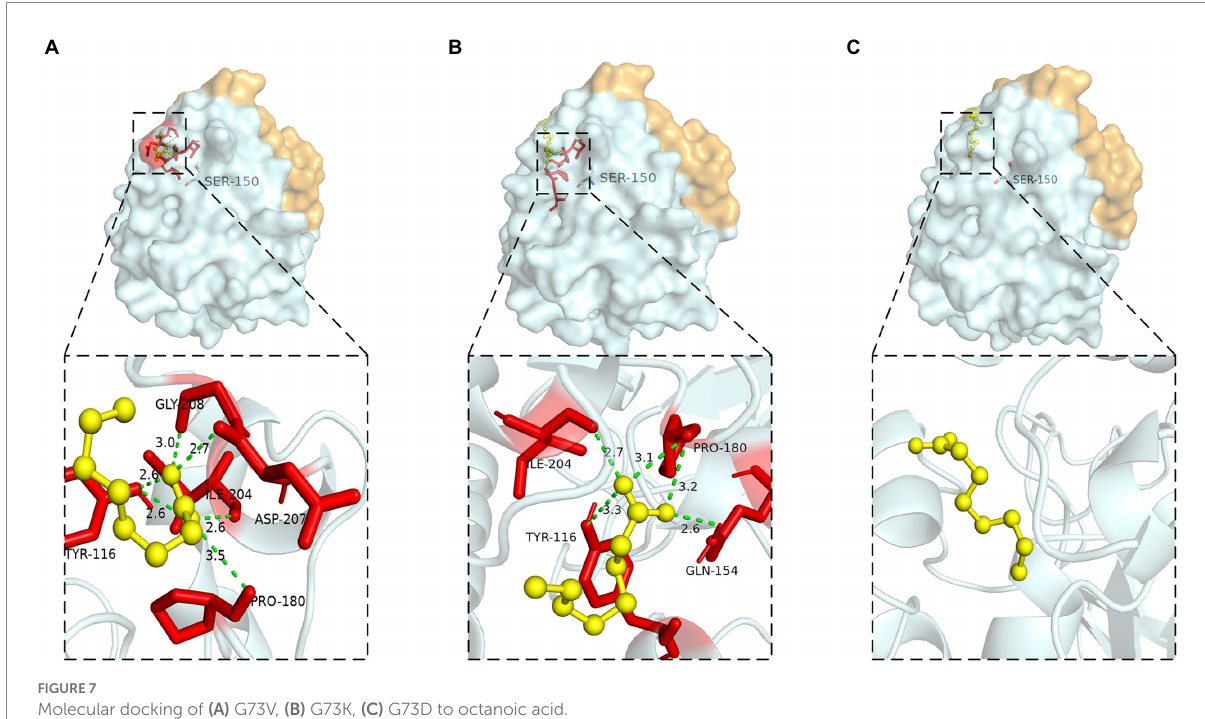
FIGURE 7 Molecular docking of (A) G73V, (B) G73K, (C) G73D to octanoic